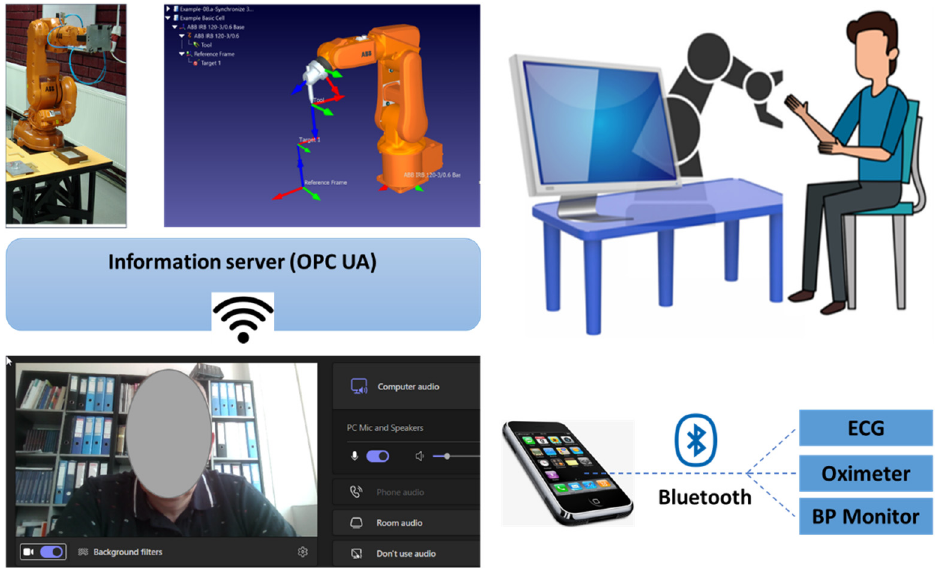
Figure 10 . Lab testing of the robotic system for upper limb mobilization. Figure 10. Lab testing of the robotic system for upper limb